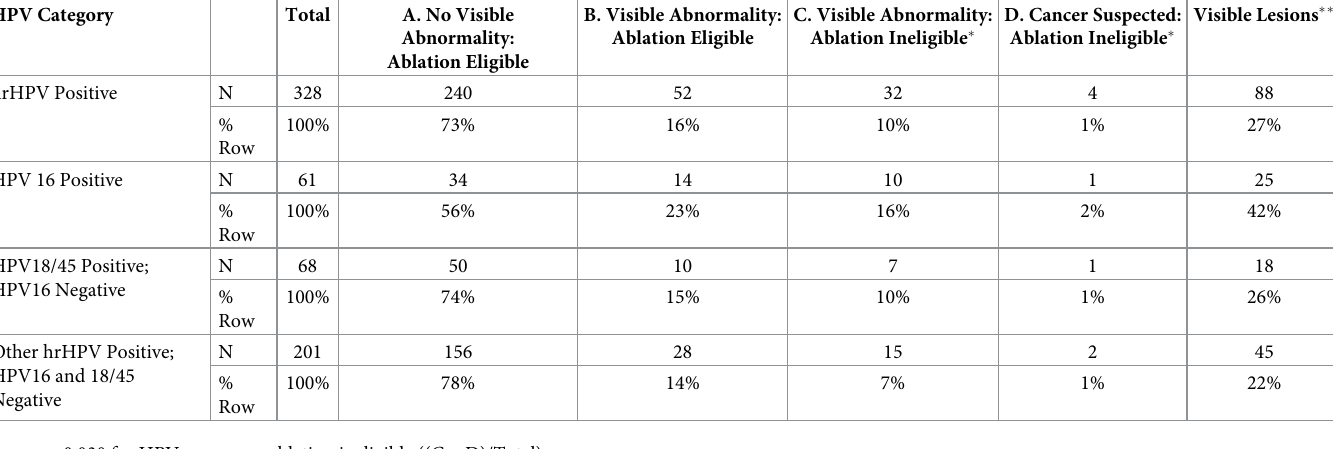
Table 5. The relationship of high-risk human papillomavirus (hrHPV) and hrHPV risk groups and results of visual assessment for treatment. HPV